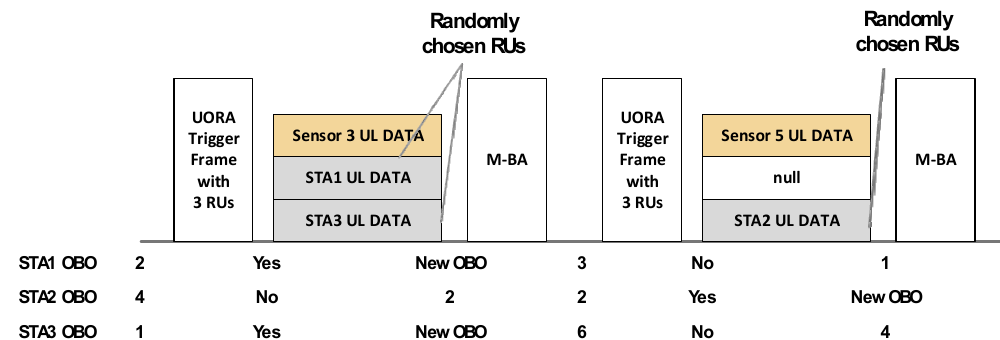
Figure 7. V2X UORA channel access procedure with dedicated resource unit(s) (RUs).